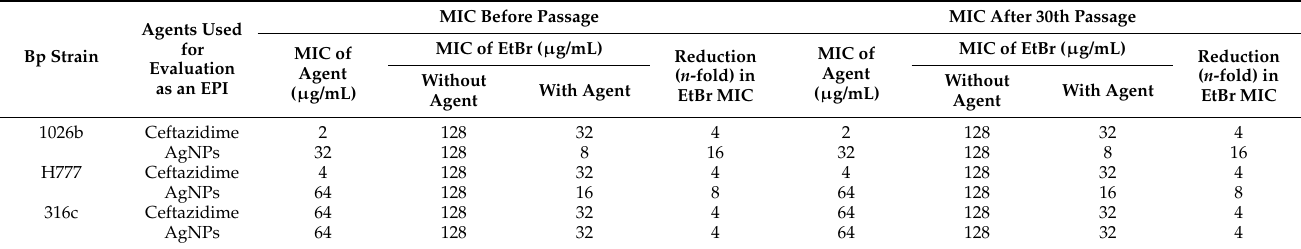
Table 3. Agents used in this study for evaluation as an efflux pump inhibitor (EPI) on the activity of EtBr, MIC of each agent before and after 30th generation passage with sublethal concentration against B. pseudomallei strain 1026b, H777 and 316c. Data represent three independent